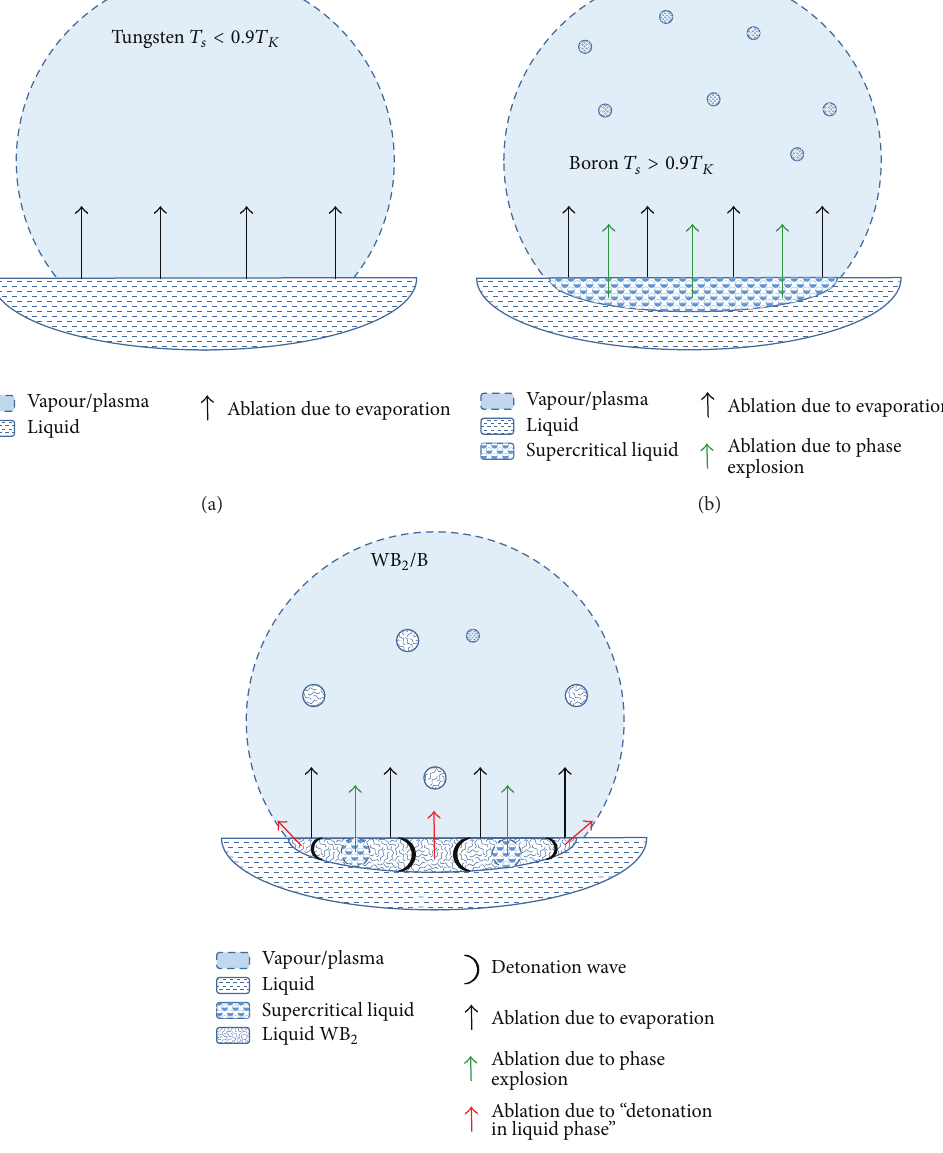
Figure 13 presents tungsten plasma position and FWHM of Lorentzian plot fitted to plasma intensity distribution. On the basis of plasma propagation and expansion in time, the plasma displacement and expansion velocity were calculated, respectively. Total velocity of plasma front is defined as a sum of both velocities mentioned above. Results are presented in The quantitative comparison of the experimental plasma shape with the theoretical results is difficult because the images show plasma radiation, which depends both on pla- sma density and temperature. However, plasma